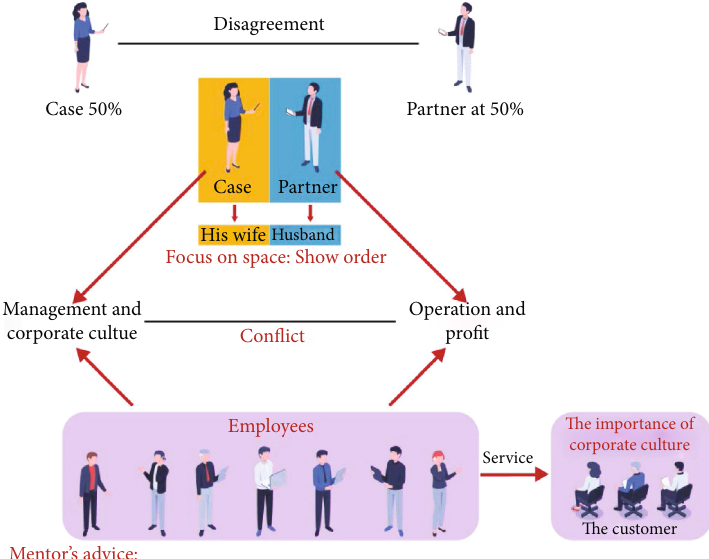
Figure 1: Basic framework of educational